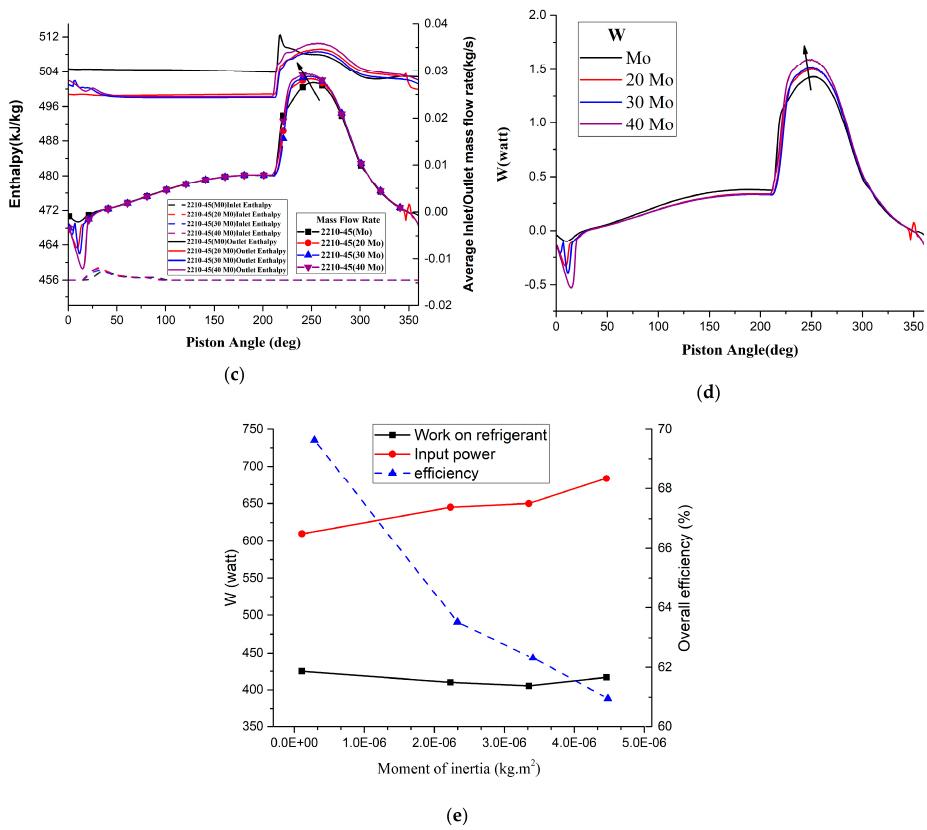
Figure 15. Physical properties due to change of mass of reed valve, from the original to 40 times mass: ( a ) mass flow rate and pressure at Inlet 1, ( b ) pressure of compression chamber at Inner 2 and opening angle of reed valve, ( c ) enthalpy at inlet/outlet and average mass flow rate, ( d ) instantaneous rate of work done on the refrigerant, ( e ) mean work done on the refrigerant, input power and overall e ffi ciency; Mo is the mass of reed valve of original type: